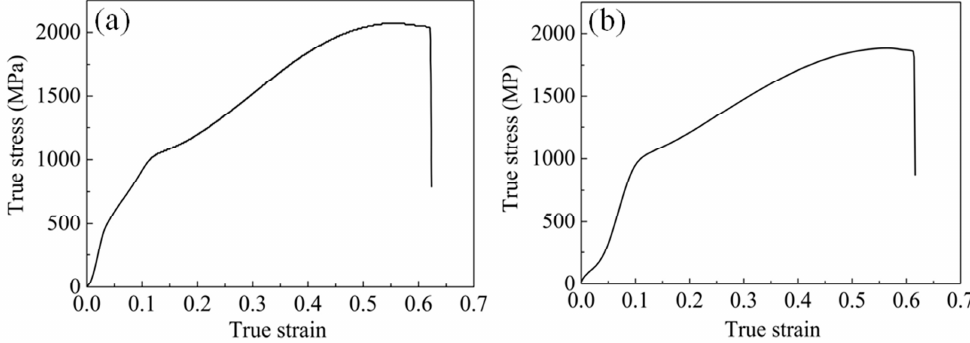
Figure 7. Compression stress–strain curves of NiTi SMAs: ( a ) Ni-49.1 at % Ti; ( b ) Ni-50 at % Ti.